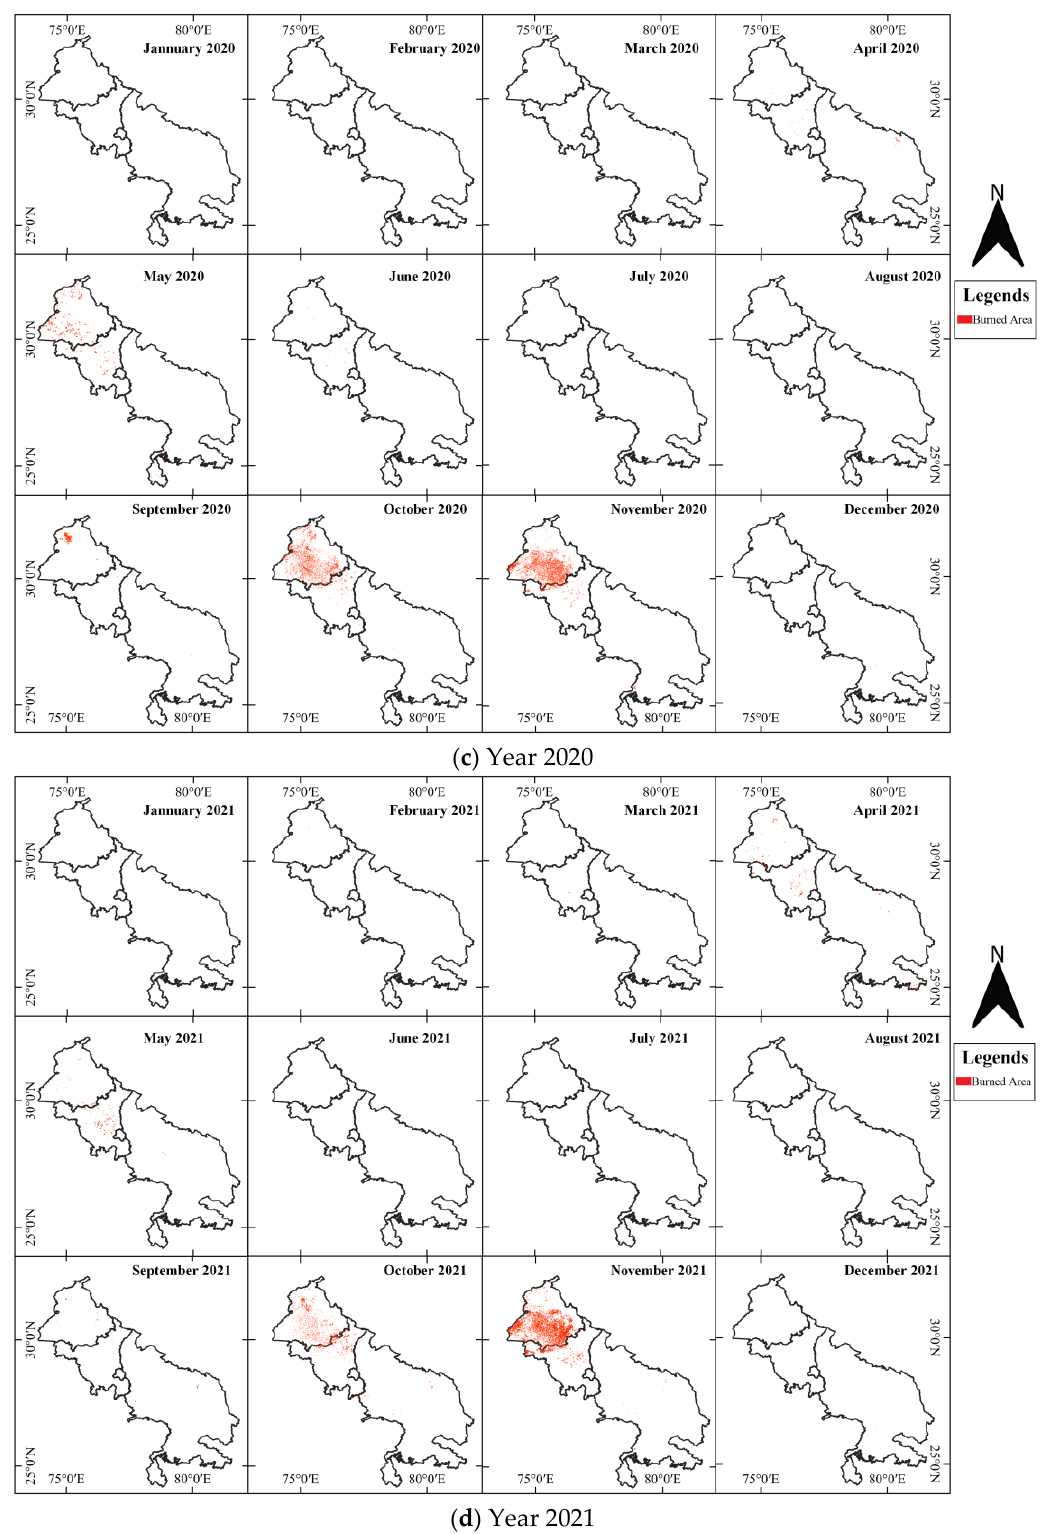
Figure 3. Representation of monthly burned area of the study site for ( a ) year 2018, ( b ) year 2019, ( c ) year 2020 and ( d ) 2021 (till November-refer to Table 2 and Figure 4 for detailed information).